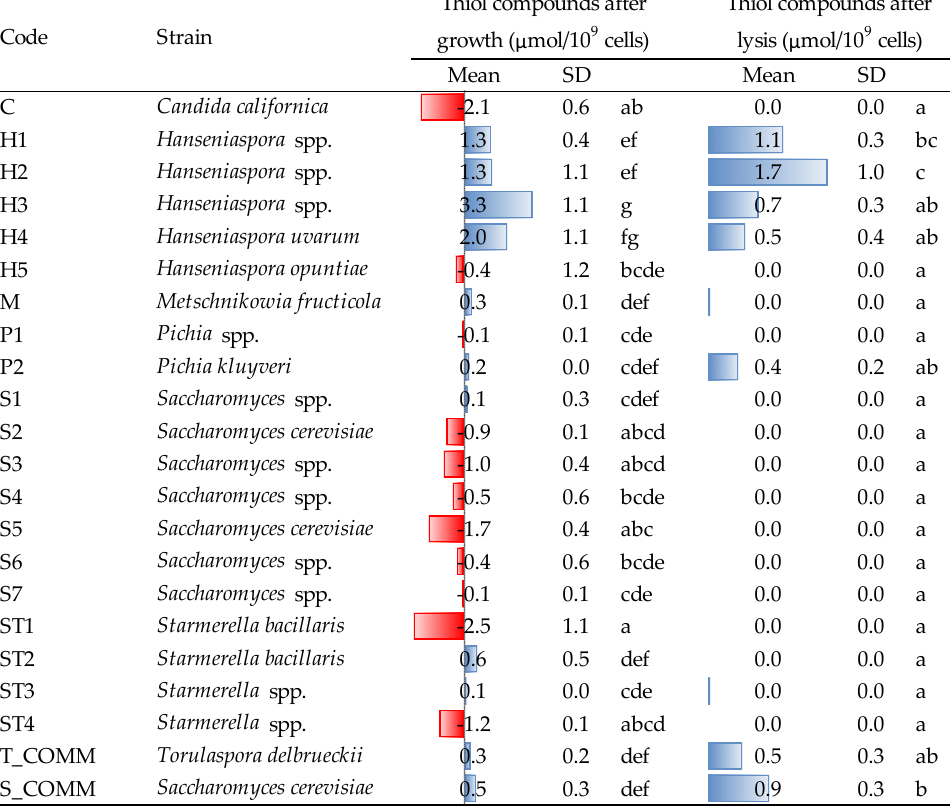
Figure 4. Thiol molecules released by the different strains after growth (48 h, YPD medium, 30 °C) and after lysis induced by β -glucanase enzymes. Data are means and standard deviations (SD) of three repetitions. Different letters mark significant differences according to ANOVA and Tukey HSD test at p < 0.05. T_COMM, S_COMM: commercial active dry yeast preparations. Concerning the values detected after growth, positive and negative values (blue and red bars) indicate, respectively, an increase/production or a decrease/consumption, with respect to the initial composition of the YPD medium.